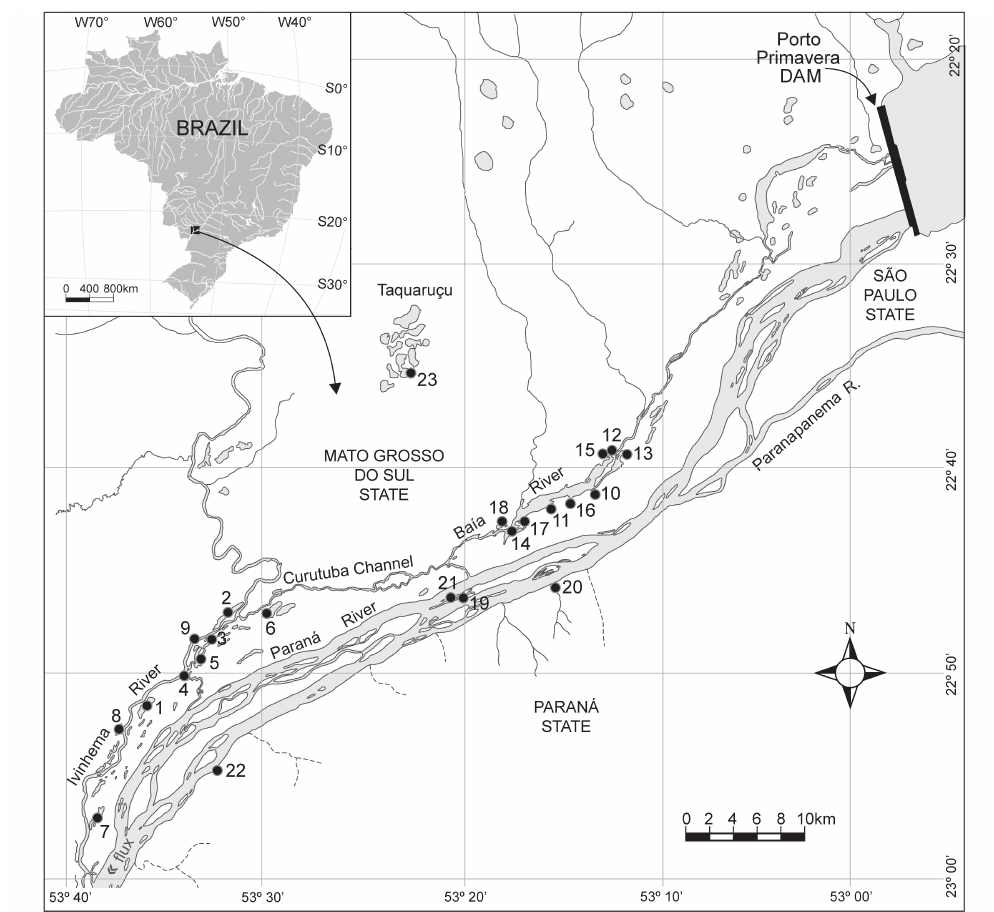
Fig. 1. Map of the study area, indicating the localities of three new species of Pseudocandona and two new species of Candobrasilopsis